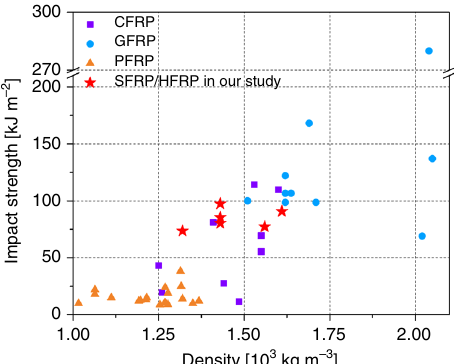
Fig. 8 Comparison of impact strength versus density. The data are derived from the composites studied in this work and CFRP, GFRP, PFRP composites from the literature. The dataset of the properties of the composites taken from the literature, with their corresponding references, can be found in Supplementary Table